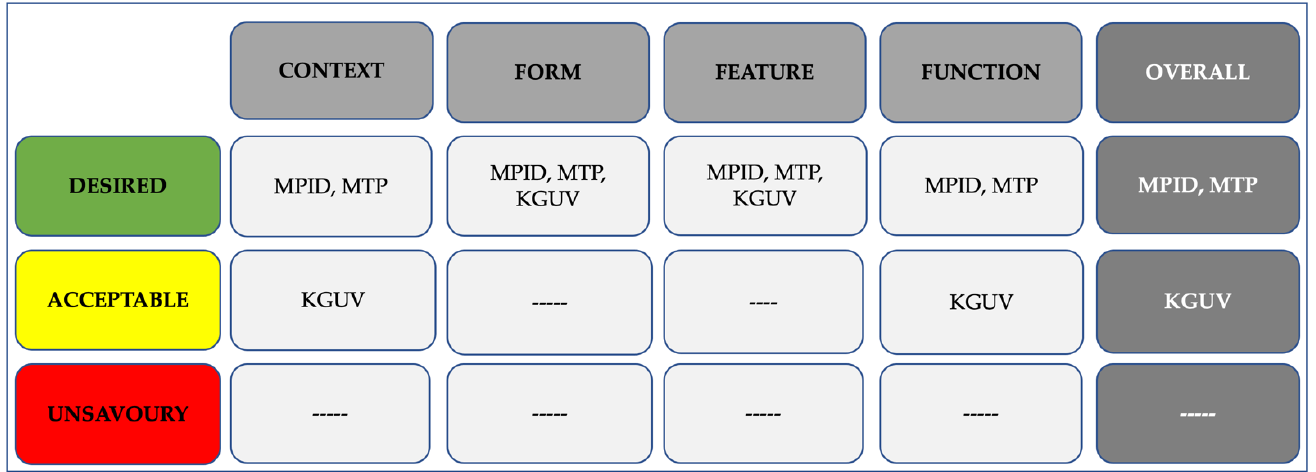
Figure5. Performance matrix of the case innovation districts. Note : MPID = Macquarie Park Inno- Figure 5. Performance matrix of the case innovation districts. Note: MPID = Macquarie Park vation District; MTP = Monash Technology Precinct; KGUV = Kelvin Grove Urban Village. Innovation District; MTP = Monash Technology Precinct; KGUV = Kelvin Grove Urban